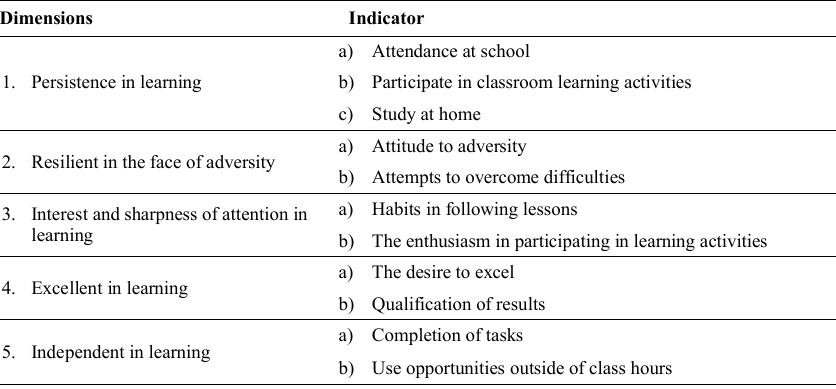
Table 3. Dimensions of Student Motivation